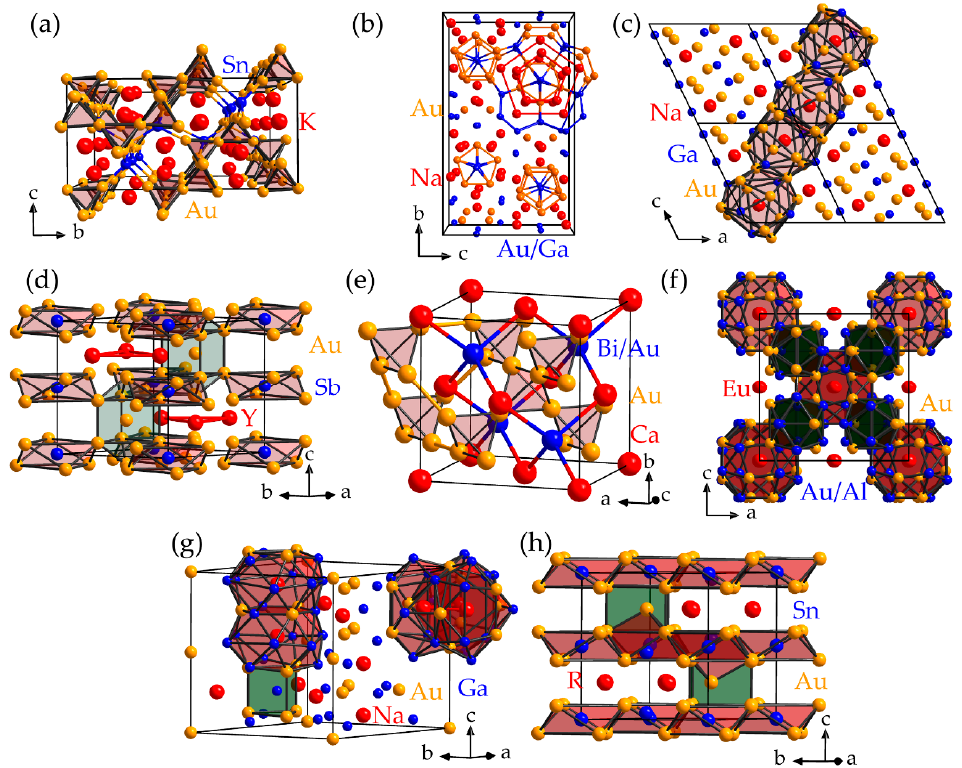
Figure 7. Representations of the crystal structures of: ( a ) K 12 Au 21 Sn 4 ; ( b ) Na 8 Au 10.1 Ga 6.9 ; ( c ) NaAu 4 Ga 2 ; ( d ) Y 3 Au 9 Sb; ( e ) CaAu 4.1 Bi 0.9 ; ( f ) EuAu 6.1 Al 5.9 ; ( g ) Na 5 Au 10 Ga 16 ; and ( h ) R 3 Au 7 Sn 3 . Details regarding the